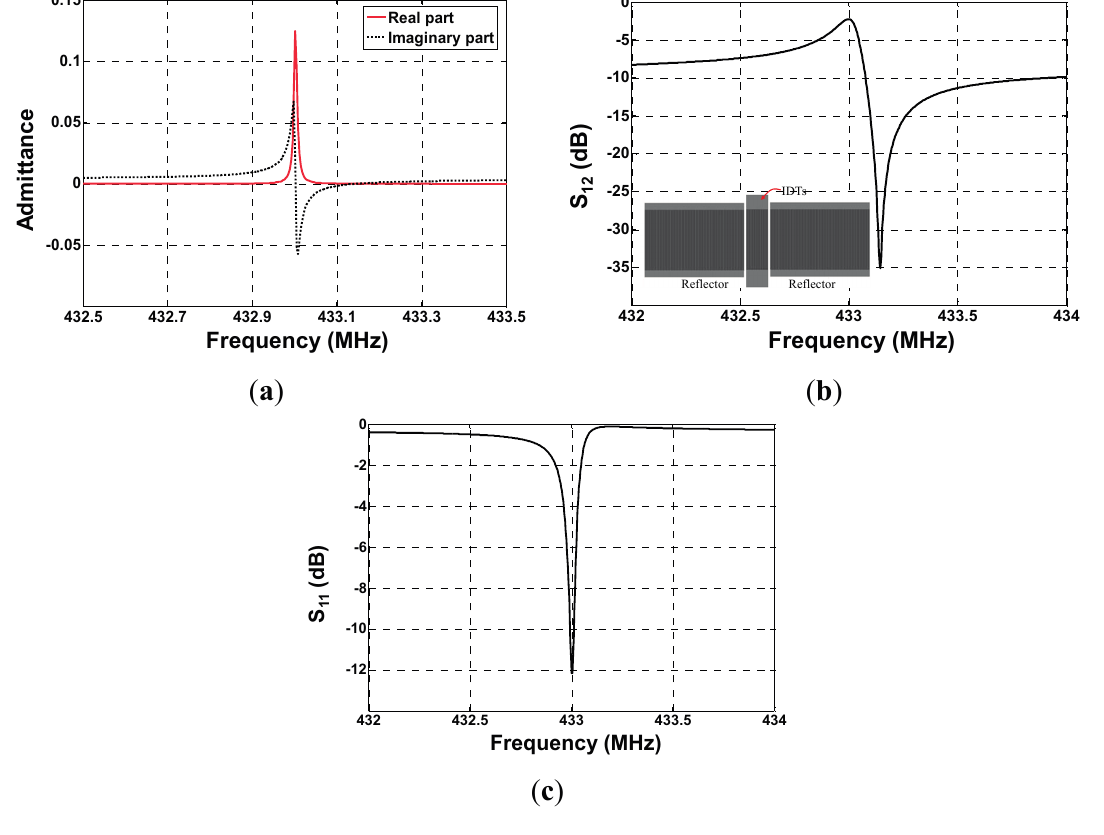
Figure 4. Coupling of Modes (COM) simulation on one-port SAW resonator, ( a ) admittance; ( b ) insertion loss (S 21 ); and ( c ) reflection coefficient S 11